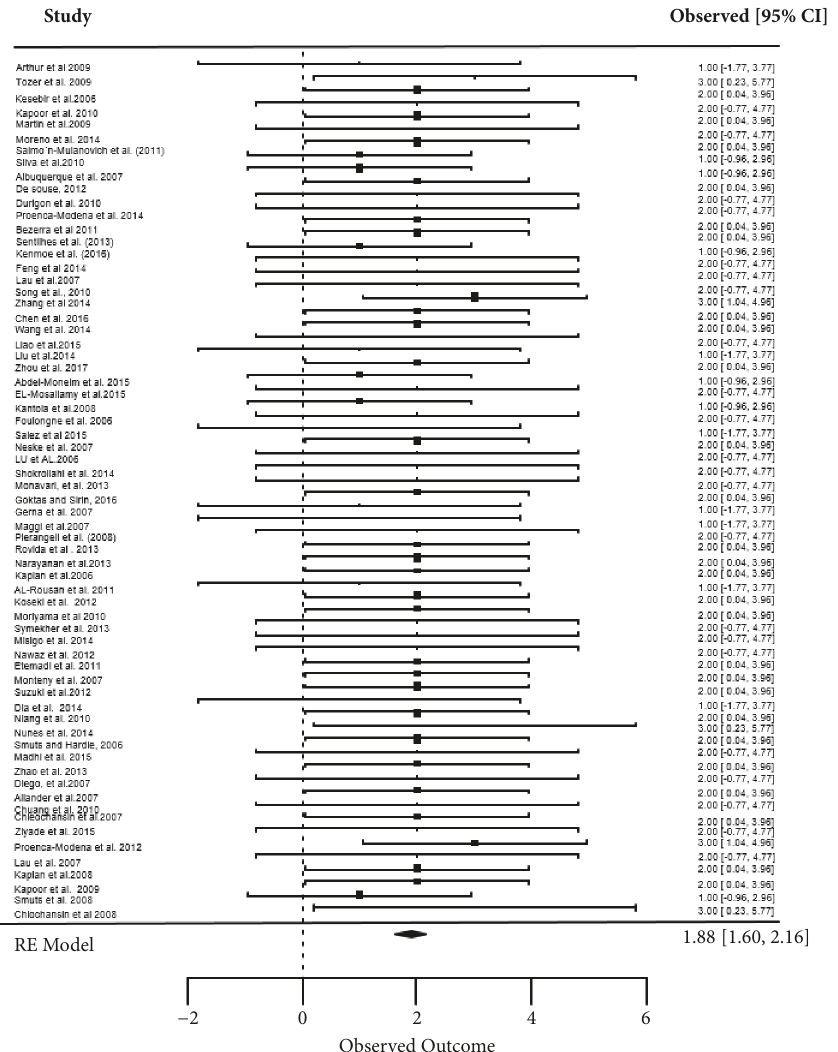
Figure 2: Forest plot for prevalence studies in detection of Human